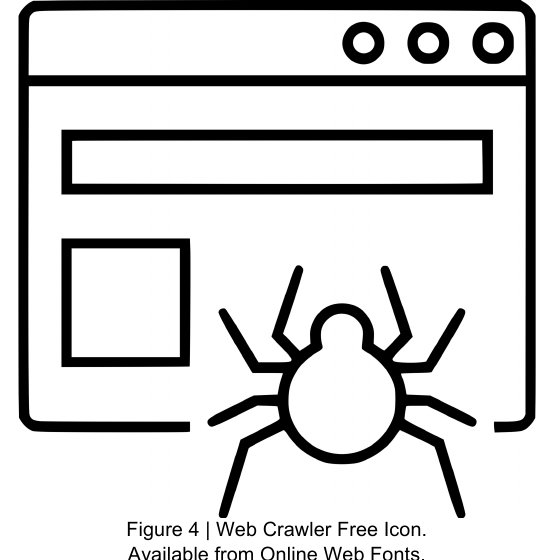
Figure 4 | Web Crawler Free